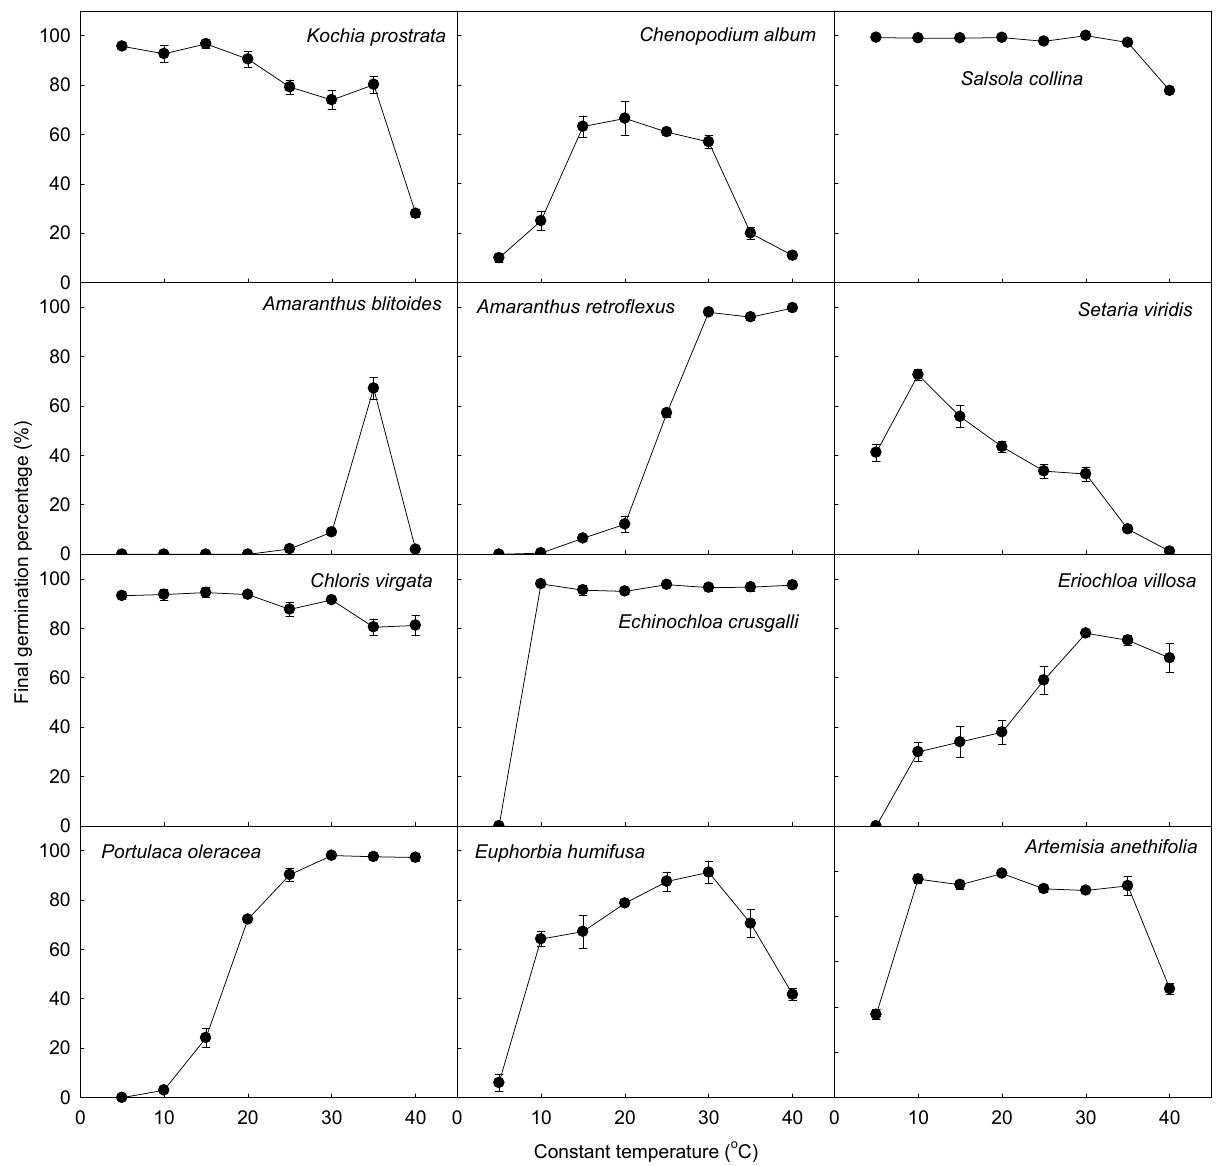
Figure 1. Final germination percentages of C 4 species at a range of constant temperatures from 5 °C to 40 °C. Bars represent ±SE ( n =